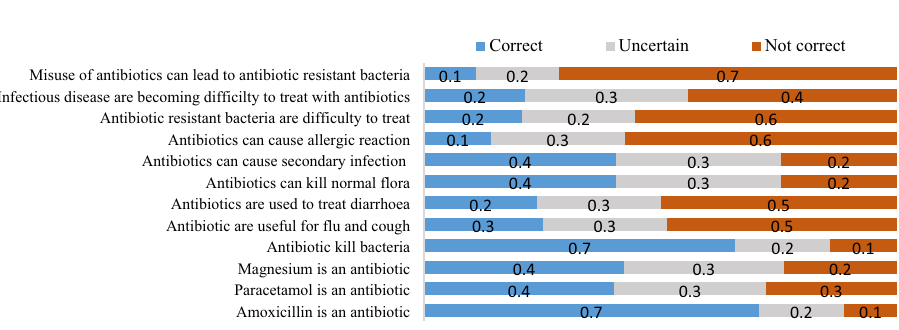
Figure 1. Knowledge on rational use of antibiotics in children among parents attending clinic at RRHs in Tanzania. In assessing the knowledge, 2726 participants responded to different questions whereby 42.3% and 40.1% knew that magnesium and paracetamol are not antibiotics, respectively. Few participants, 11% had the knowledge that misuse of antibiotics can lead to AR while 21.4% had adequate knowledge on